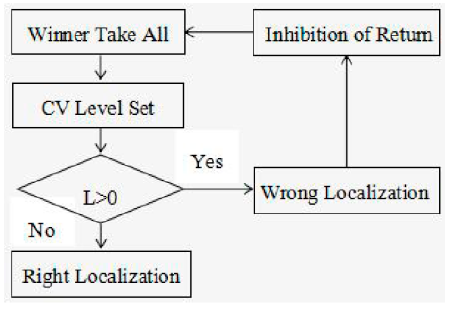
Figure 10. The workflow of post processing for wrong localization results.